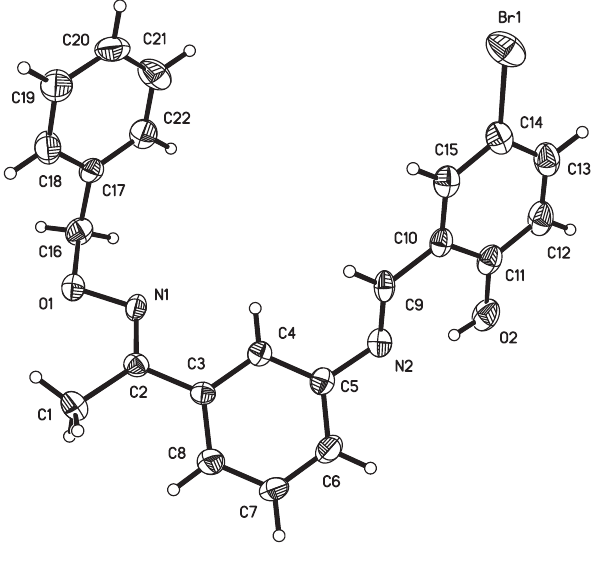
Table 1: Data collection and